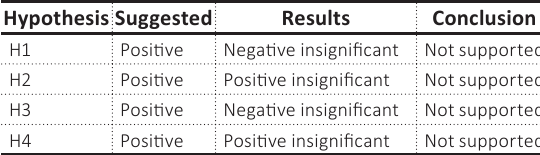
Table 8. Hypotheses testing